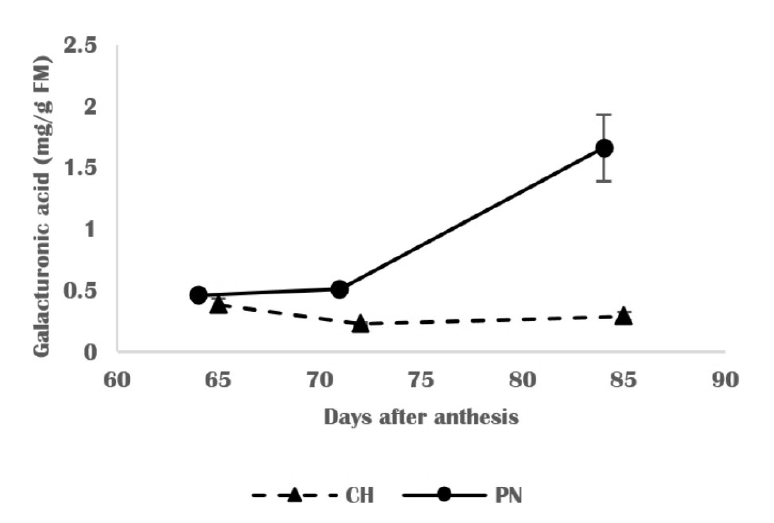
Figure 5. Galacturonic acid content for Pinot noir ( • ) and Chardonnay ( (cid:78) ) skin cell walls during ripening. Means of 3 replications ±